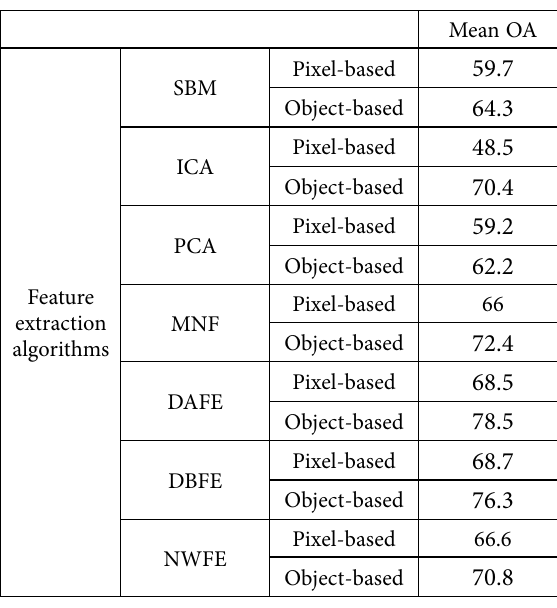
Table 3. Mean performance of feature extraction